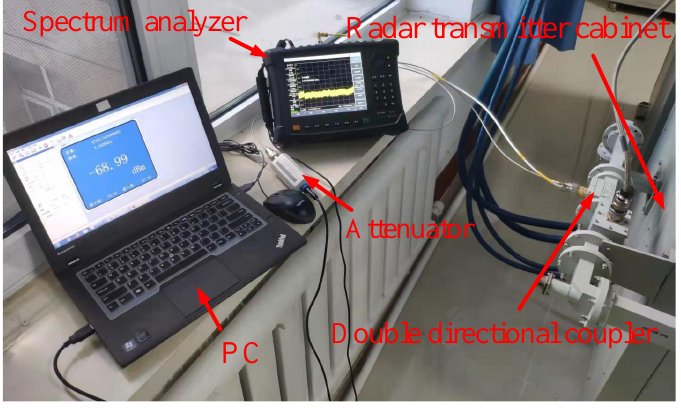
Figure 3. The hard-wired settings of the